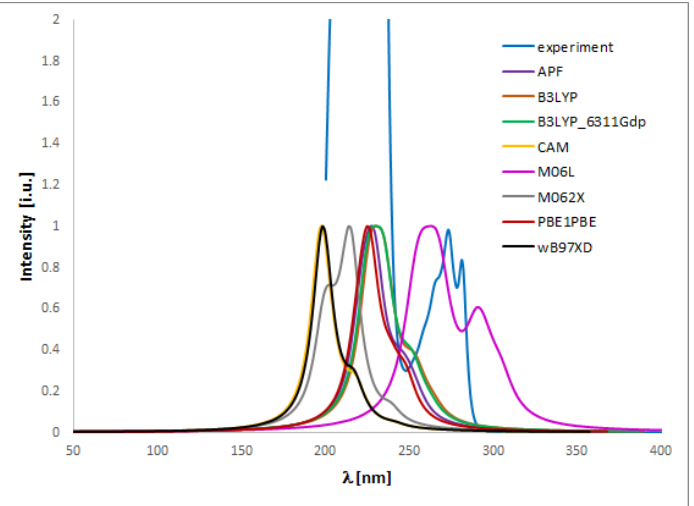
Figure 6. Experimental (experimental) and theoretical UV-vis spectra of isoconazole 1 registered in methanol and computed using CPCM solvation model (methanol as solvent); approximations: APF